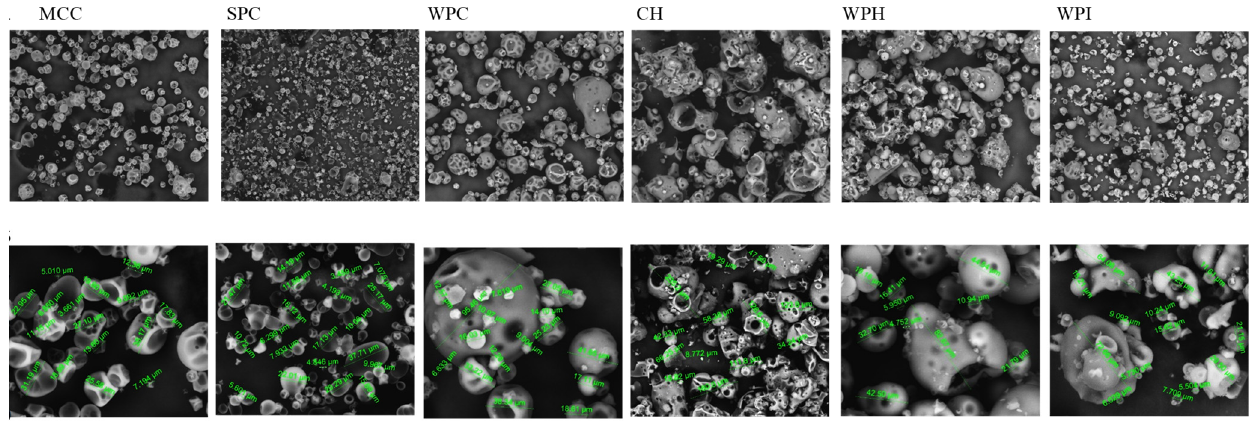
Figure 2. Micrographs of high-protein milk powders at 200 × ( upper row ) and 800 × ( bottom row ) magnification.